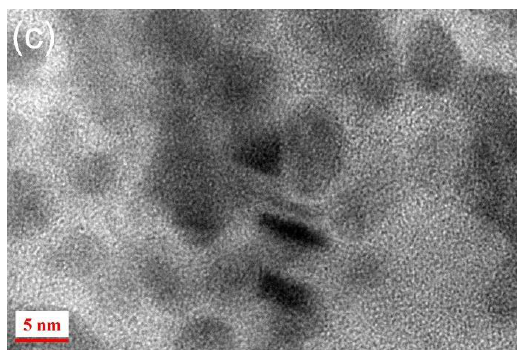
Figure 4 . ( a ) Selected area electron diffraction (SAED) pattern; ( b ) HR (High resolution)-TEM image of Si/C nanocomposite electrode; and ( c ) HR-TEM image of the Si/C nanocomposite electrode after 100th cycle.